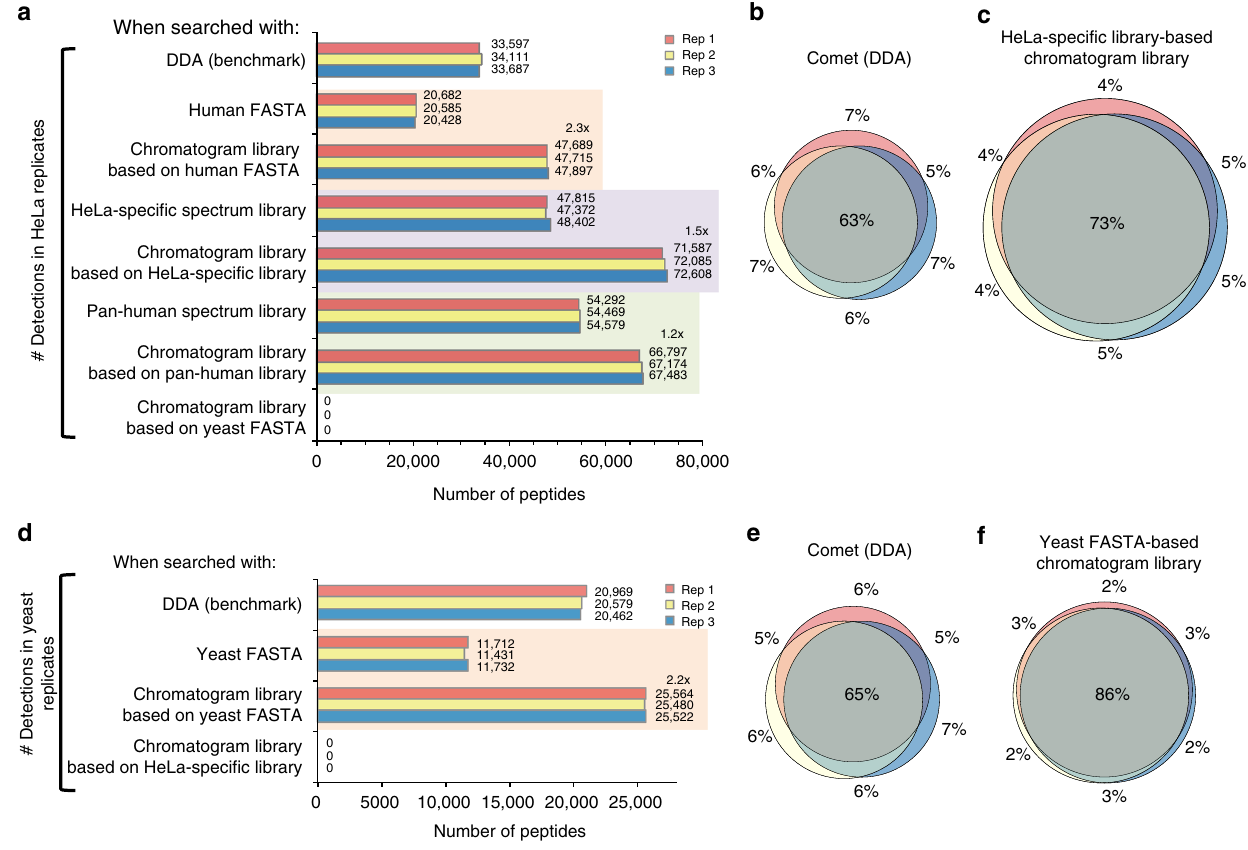
Fig. 2 Untargeted peptide detections using DDA and DIA. We used EncyclopeDIA to search chromatogram and spectrum libraries, while we used Comet and Walnut to search DDA and DIA data directly using FASTA protein databases. Every search was performed independently without any run-to-run alignment. a The number of peptide detections at 1% peptide FDR in triplicate HeLa injections. Orange shaded areas indicate pairwise comparisons of FASTA searches versus FASTA-based chromatogram library searches. Purple (or green) shaded areas indicate pairwise comparisons of searches of a cell line-speci fi c DDA library (or the Pan-Human DDA library) versus a chromatogram library derived from that DDA library. b The overlap in HeLa S3 peptide detections between replicates using DDA searched by Comet and c using DIA searched by EncyclopeDIA where the size of Venn diagram circles in HeLa analyses are consistent with the number of detections. d The number of peptide detections at 1% peptide FDR in triplicate BY4741 yeast injections. e The overlap in yeast peptide detections between replicates using DDA searched by Comet and f using DIA searched by EncyclopeDIA where the size of circles are consistent with the number of yeast peptide